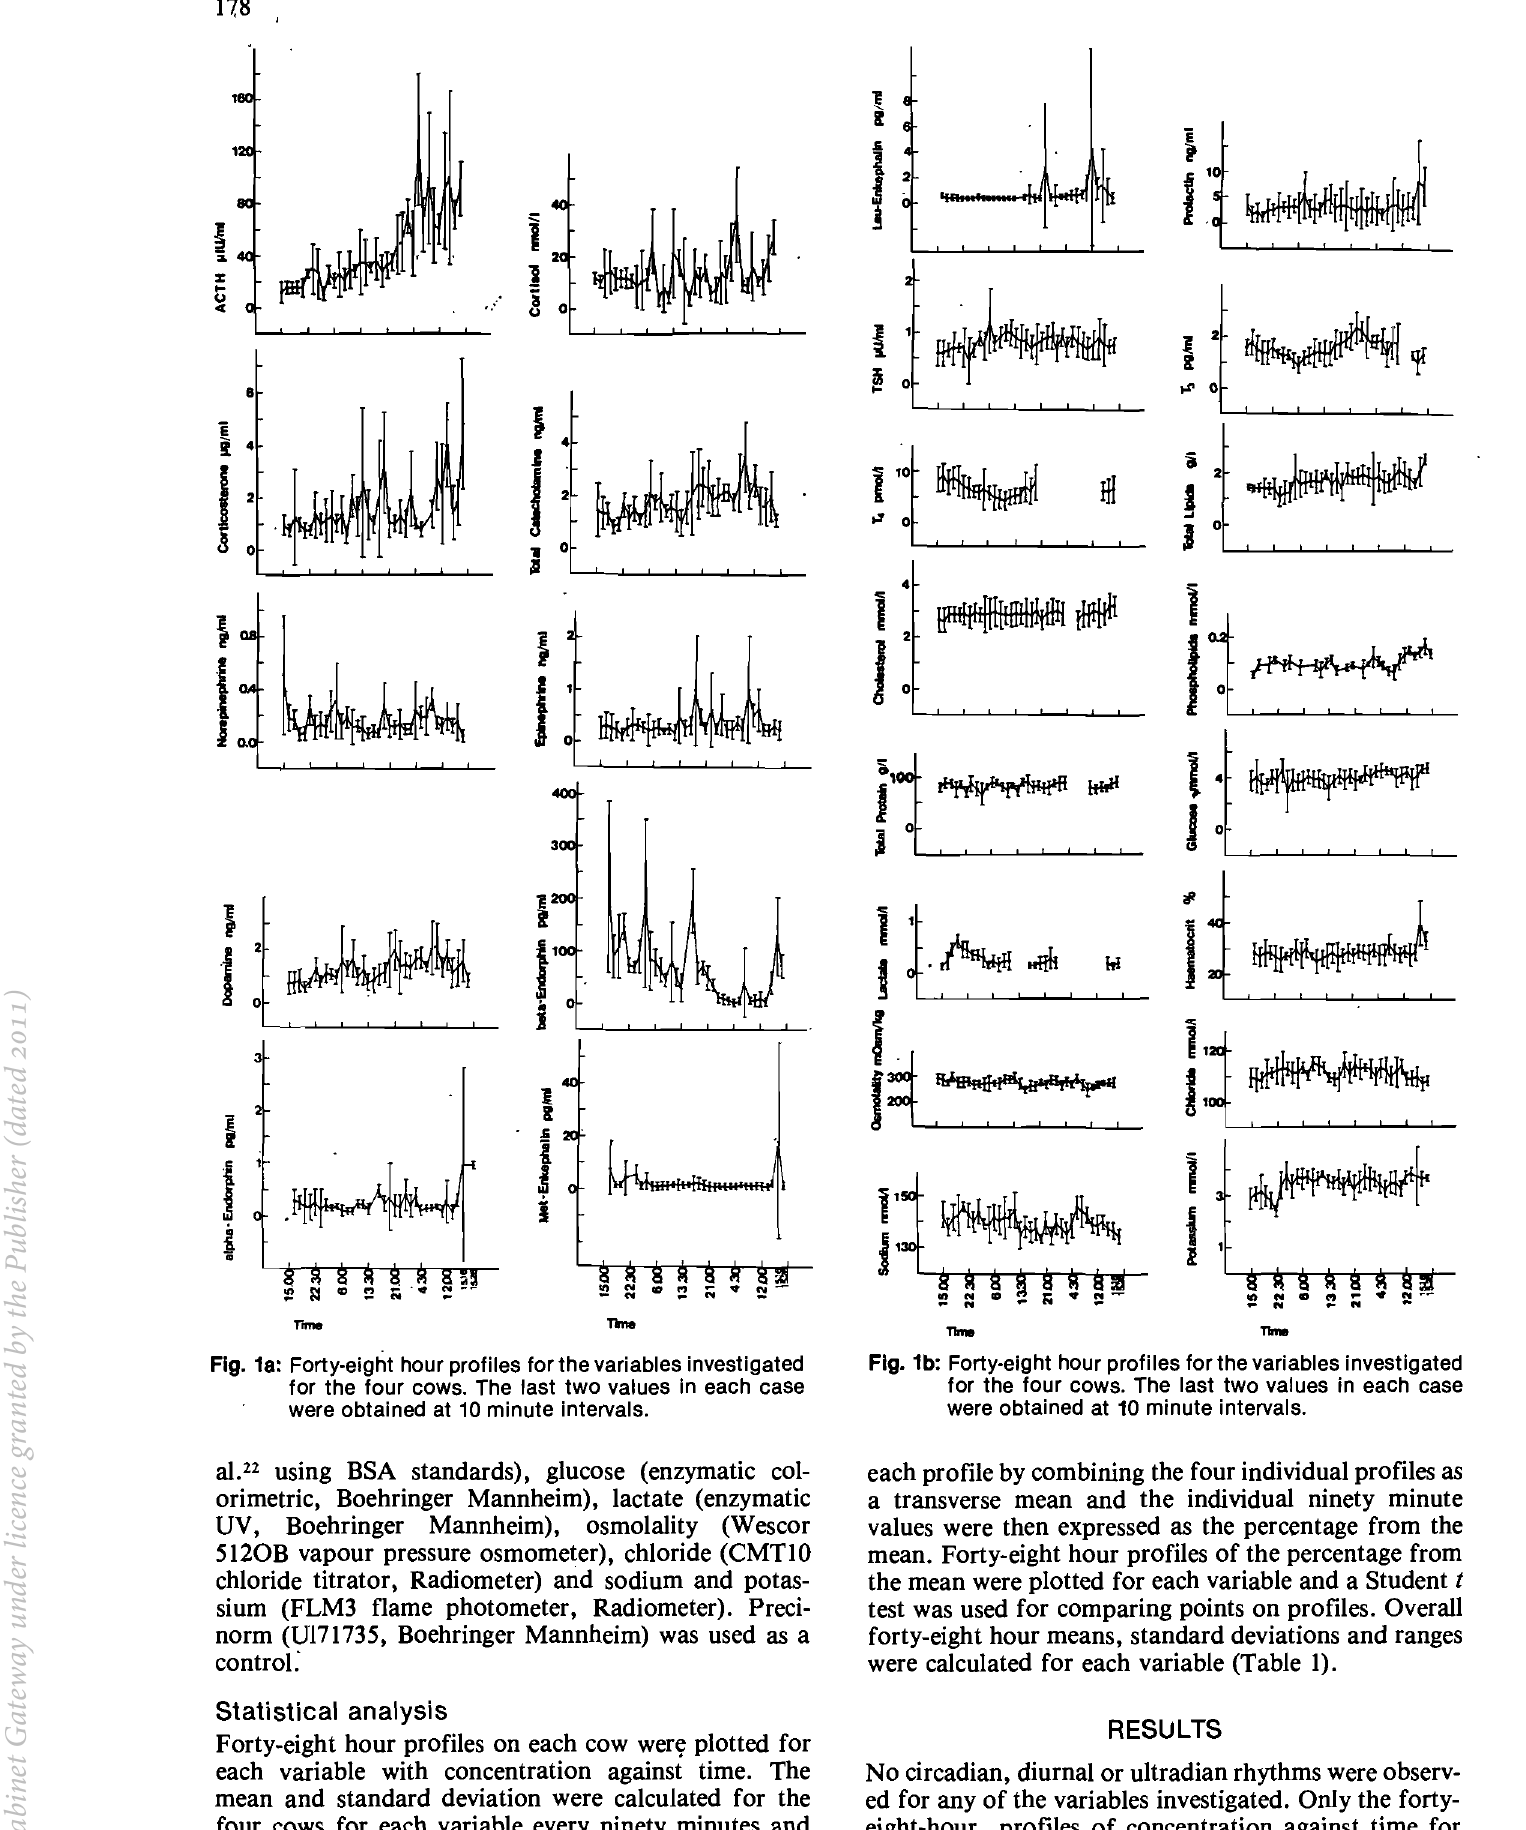
Fig. 18: Forty·eight hour profiles for the variables investigated for the four cows. The last two values in each case were obtained at 10 minute intervals.